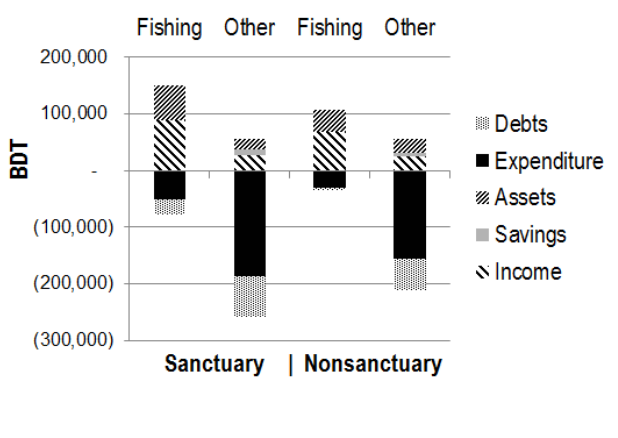
Fig. 3. Balance of fishing-related household income, assets, expenditure, and debts vs. nonfishing related (“Other”) household income, assets, savings, expenditure, and debts; comparison between sanctuary and nonsanctuary fishing